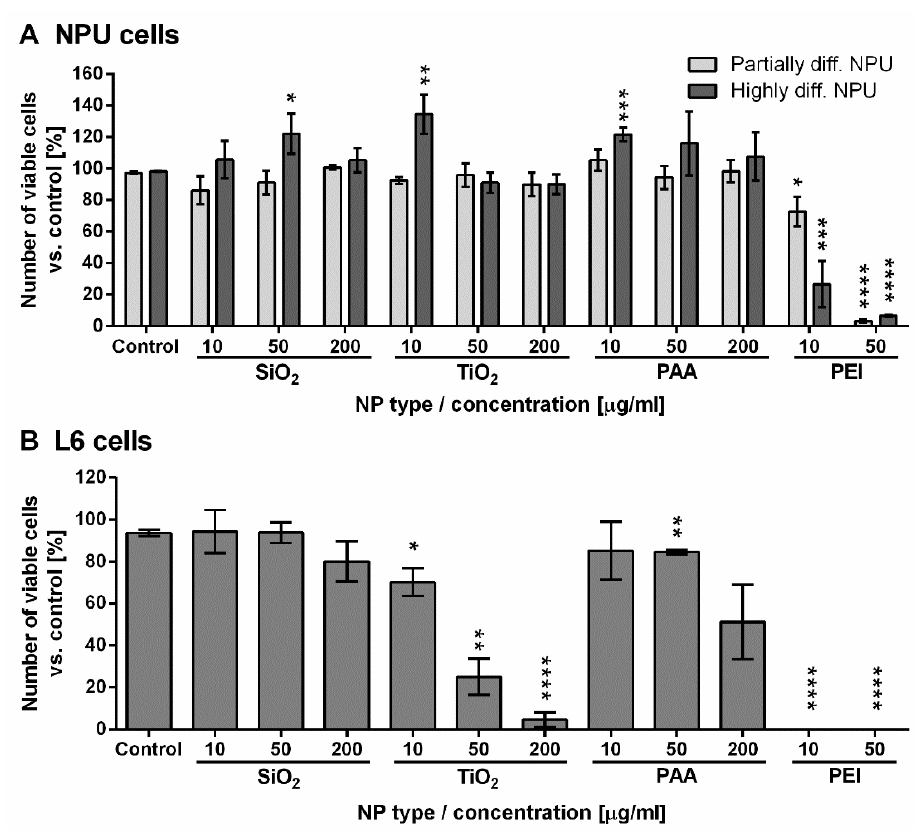
Figure 2. Short-term assessment of NPU and L6 cell viability for 96 h exposure to NPs. Viability of ( A ) highly and partially di ff erentiated NPU cells and ( B ) L6 cells following 96 h of exposure to increasing concentrations of SiO 2 , TiO 2 , PAA, and PEI NPs. The results are presented as the percentage of viable cells compared to the number of all cells in the control sample for each cell type. Mean and standard error are shown. (Partially di ff erentiated NPU; SiO 2 , PAA, and PEI n = 4; TiO 2 n = 2; highly di ff erentiated NPU; SiO 2 10 and 50 µ g / mL, n = 2; SiO 2 200 µ g / mL, n = 3; TiO 2 , n = 2; PAA NPs 10 µ g / mL, n = 2; PAA NPs 50 and 200 µ g / mL, n = 3; PEI, n = 2; L6 cells, n = 3; n stands for the number of independent experiments, each performed in three replicates). Statistical significance is displayed as follows: * p ≤ 0.05; ** p ≤ 0.01; *** p ≤ 0.001; **** p ≤ 0.0001.